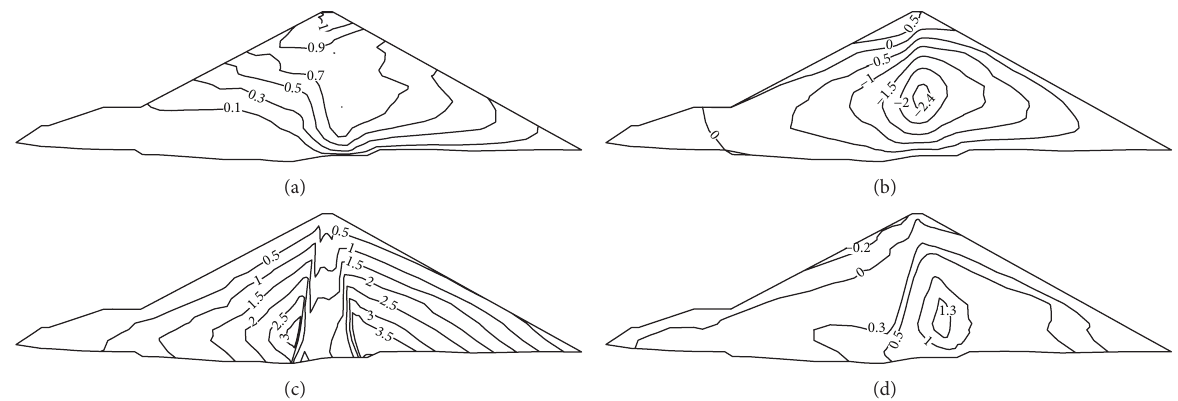
Figure 11: Displacement and stress contour of the maximum section for Duncan and Chang’s EB model: (a) displacement along river (m), (b) vertical displacement (m), (c) major principle stress (MPa), and (d) minor principle stress (MPa).